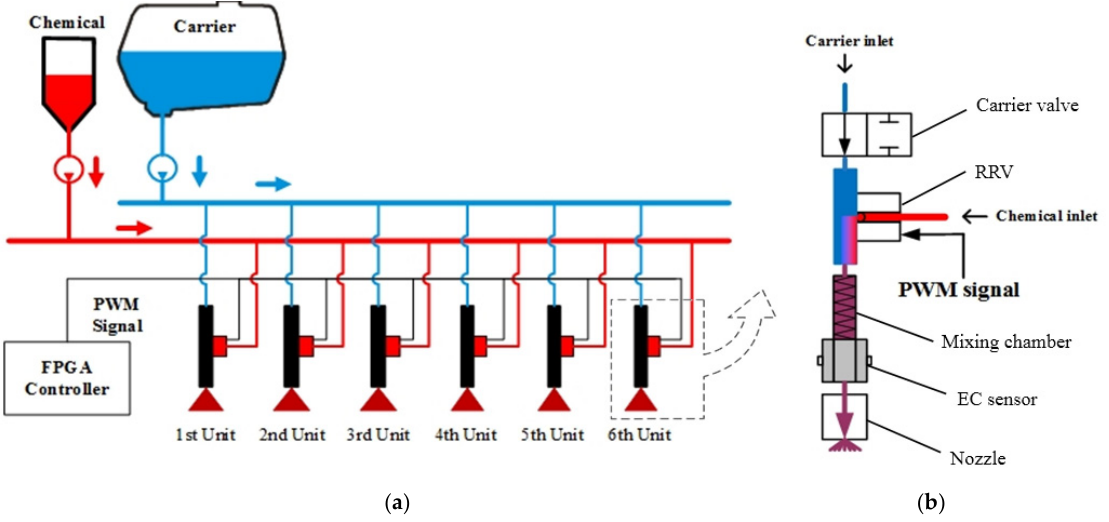
Figure 2. ( a ) Schematic structure of the experimental setup with a boom section; ( b ) one of the injection units.